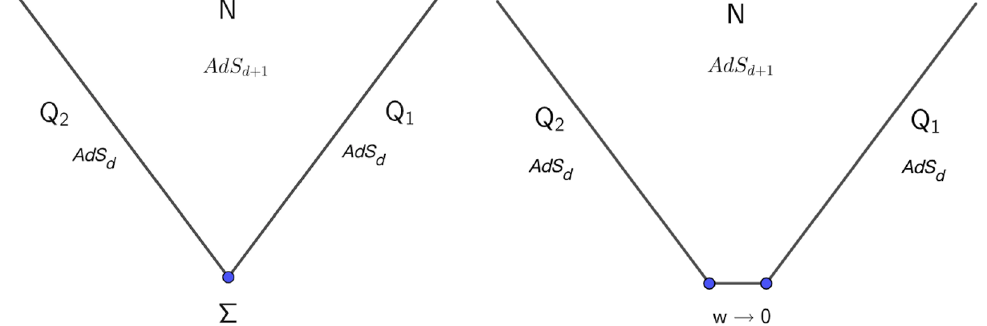
Figure 1 . (Left) Geometry of wedge holography; (right) Wedge holography from AdS/BCFT. the wedge. See also [32] for a similar proposal of codimension two holography. The